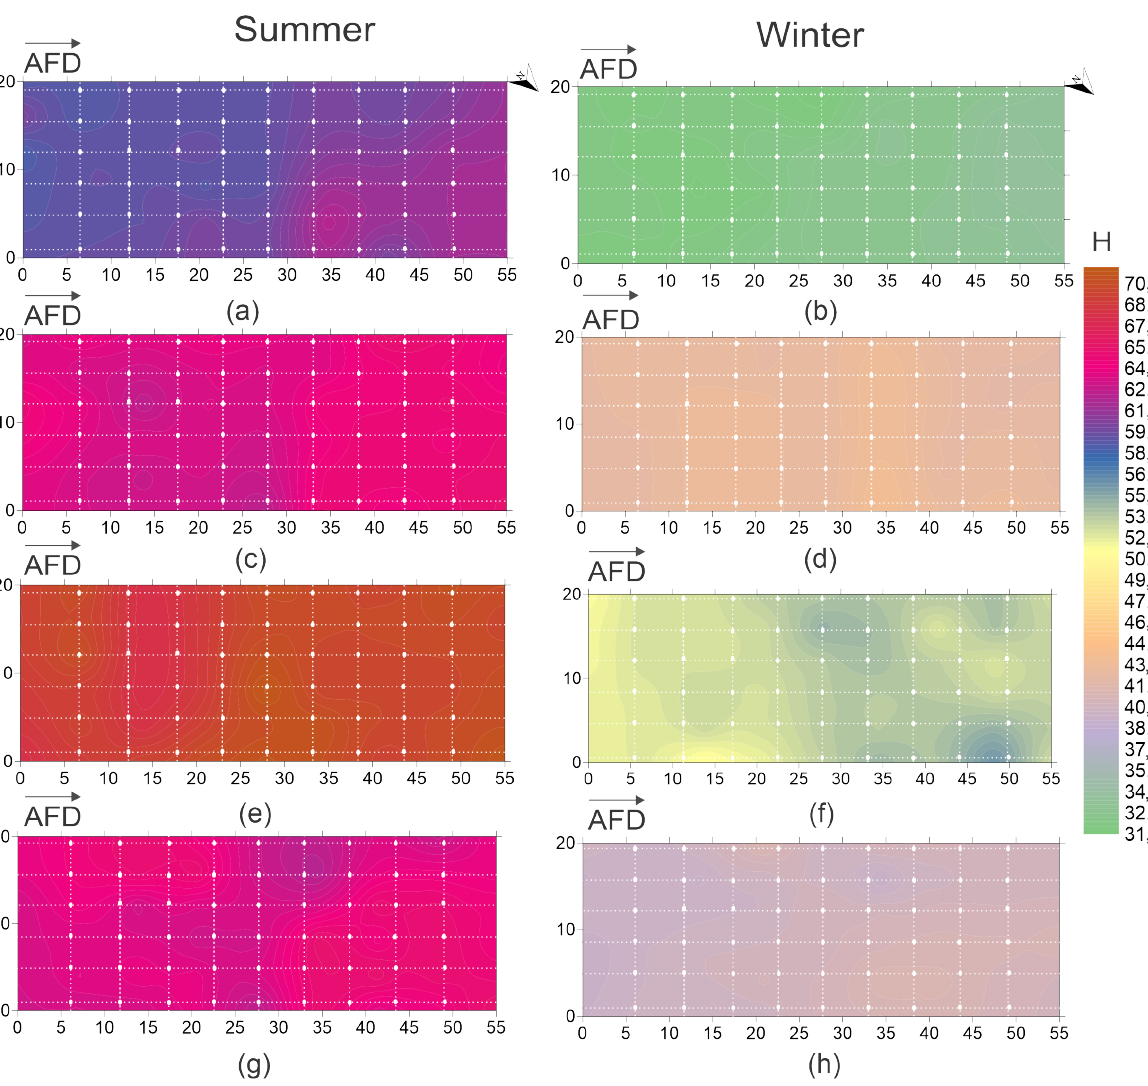
Figure 8. Spatial distribution of Enthalpy (H, kJ kg dry air-1) during the dawn (00:00a.m. to 05:00a.m.), morning (06:00a.m. to 11:00a.m.), afternoon (12:00p.m to 05:00pm) and night (06:00p.m. to 11:00p.m.) inside the compost bedded pack barn (CBP) during the summer and winter experimental